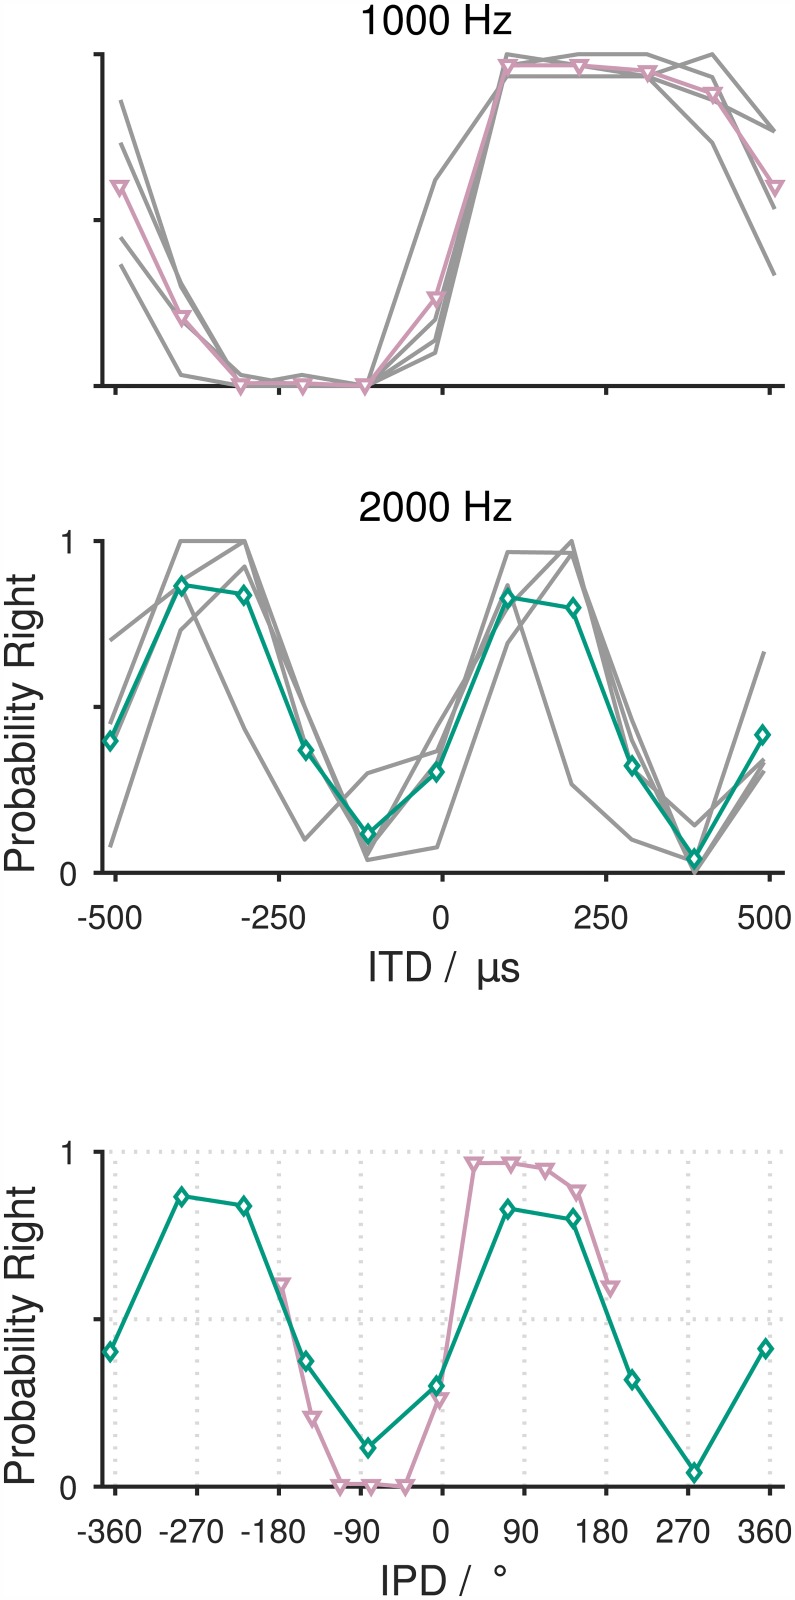
Behavioral responses to tones with ITD outside the naturally occurring range.(A) Probability of responses to the right as a function of ITD measured at 1000 and 2000 Hz for an ITD range between -510 and 510 μs. Responses of four animals are shown in grey. The mean responses at 1000 and 2000 Hz are depicted in purple (triangles) and green (diamonds), respectively. (B) Probability of response to the right as a function of IPD measured at 1000 Hz (purple) and 2000 Hz (green).